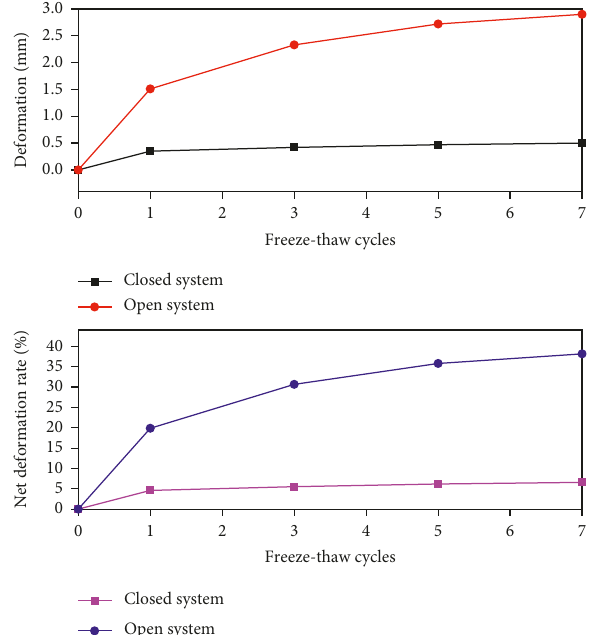
Figure 5: Variation of deformations and net deformation rate of specimens with the freeze-thaw cycles.